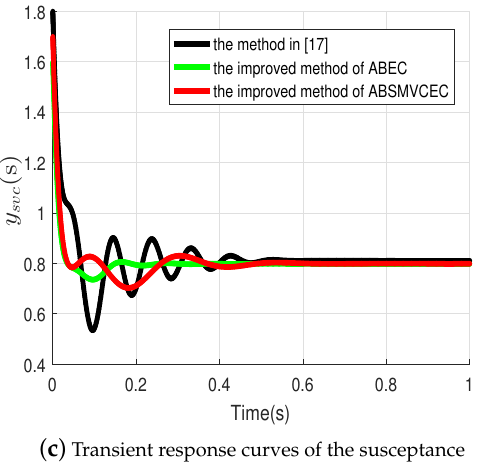
Figure 3. ( a – c ) are simulation results for the system (1) in small